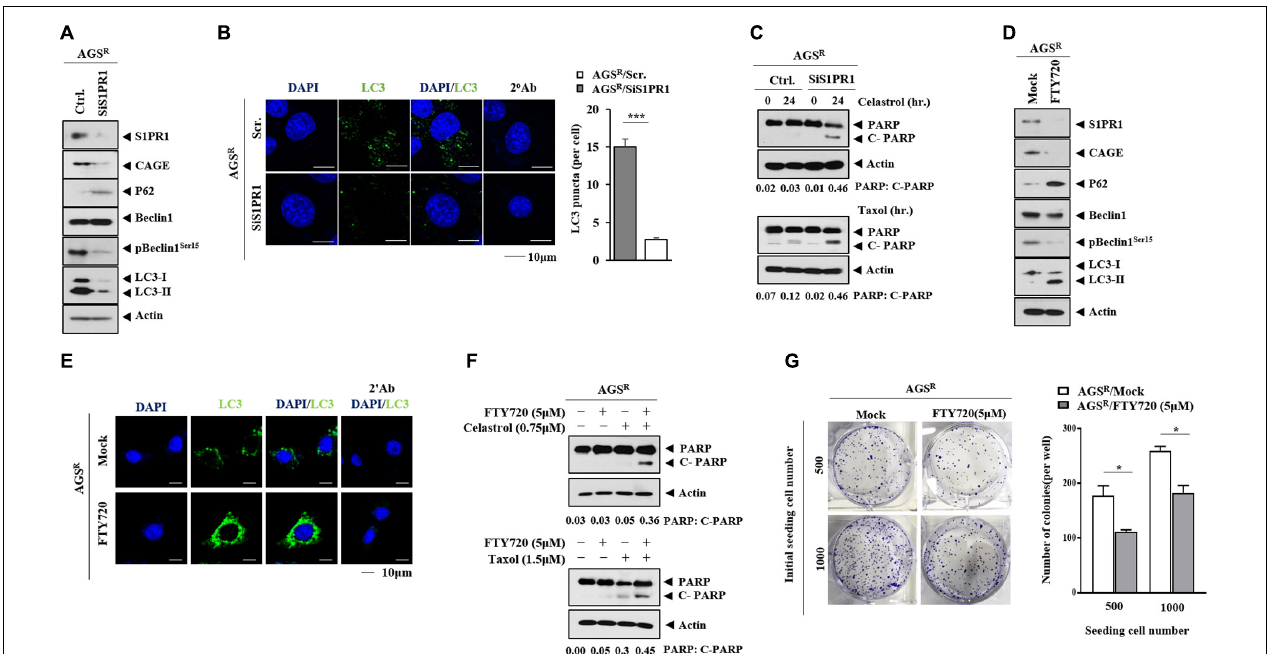
FIGURE 10 | S1PR1 regulates autophagic flux and anticancer drug resistance. (A) After 48 h of transfection, immunoblot was performed. Representative blots of three independent experiments are shown. (B) The number of LC3 puncta was determined. ***, p < 0.001. (C) After 24 h of transfection, cells were then treated with or without the indicated anticancer drug for 24 h. Representative blots of three independent experiments are shown. (D) The indicated cancer cells were treated with or without FTY720 (5 µ M) for 24 h. Representative blots of three independent experiments are shown. (E) Immunofluorescence staining was performed. (F) AGS R cells were treated with or without FTY720 (5 µ M) for 24 h. Cells were then treated with the anticancer drug for 24 h. Representative blots of three independent experiments are shown. (G) Colony-forming potential was determined. *, p < 0.05. Average values of three independent experiments are